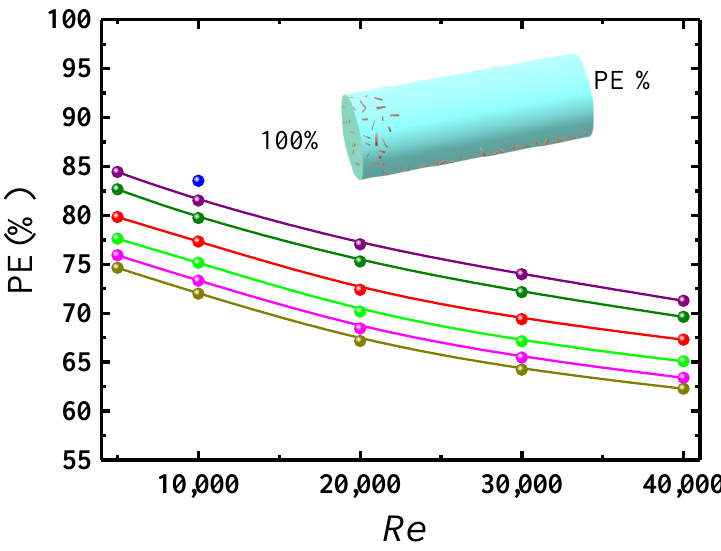
Figure 11. Penetration efficiency as a function of Re for different aspect ratios ( L/D = 200). ●: λ = 1; ●: λ = 2; ●: λ = 4; ●: λ = 8;●: λ = 12;●: λ = 16; ●: experimental result (spherical particle) [27].